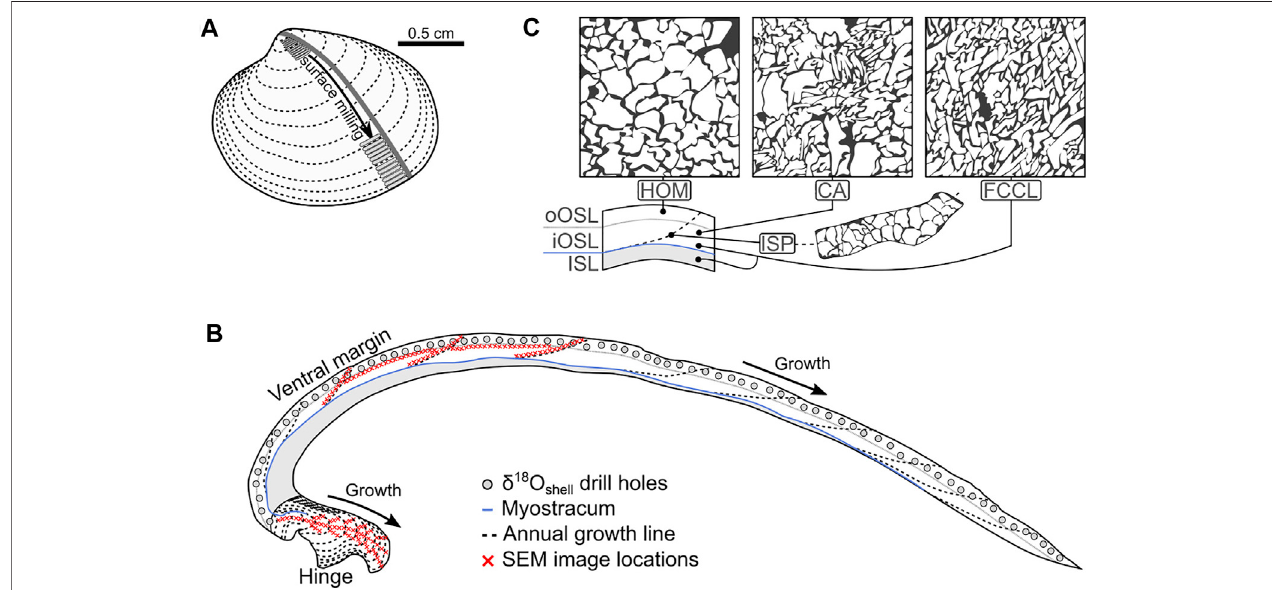
FIGURE1| Sketchof Arcticaislandica showingshellpreparation,samplingstrategyforstableoxygenisotopeandSEManalysis,andmicrostructure. (A) Twoslabs were cut from the valves along the axis of maximum growth (gray line). (B) Polished side of a shell slab; Shell powder samples were obtained by surface milling [gray swaths, (A) ], or by drilling in cross-sections [gray holes, (B) ]. The shell microstructure was studied under the SEM in the hinge plate and in the ventral shell portion (in the outer shell layer, OSL). To assess spatial variation of BMU size within each of the respective shell portions, image transects were generated along contemporaneously formed regions in the OSL (following annual growth lines) and in transects away from the maximum growth axis of the hinge plate [ (B) , specimen ICE06-6.2-A6R]. (C) Sketchesshowingthehomogeneous(HOM),crossed-acicular(CA)and fi necomplexcrossed-lamellar(FCCL)microstructures,andwheretheyare present within the ventral margin of the shell. oOSL: outer portion of the OSL; iOSL: Inner portion of the OSL; ISL: Inner shell layer.